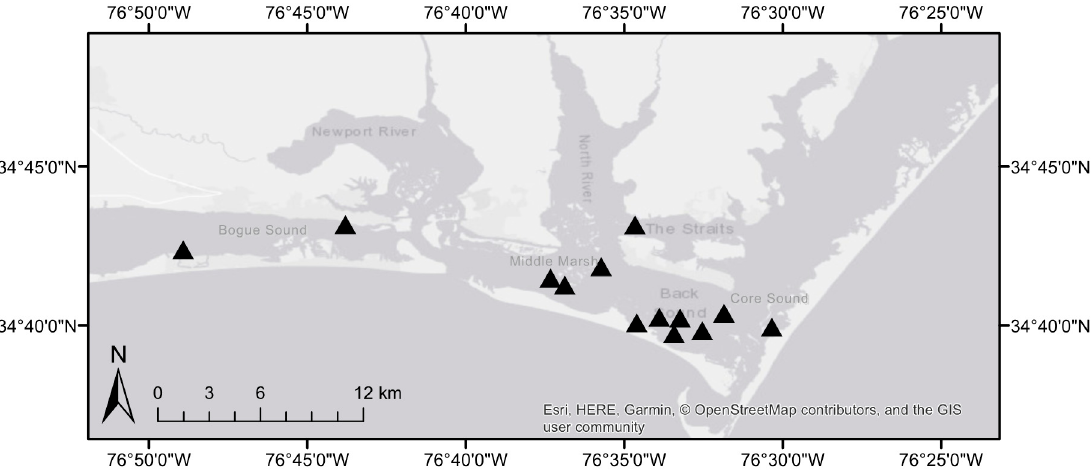
Figure 1. Survey locations (n = 13) of seagrass beds and adjacent sand flats.